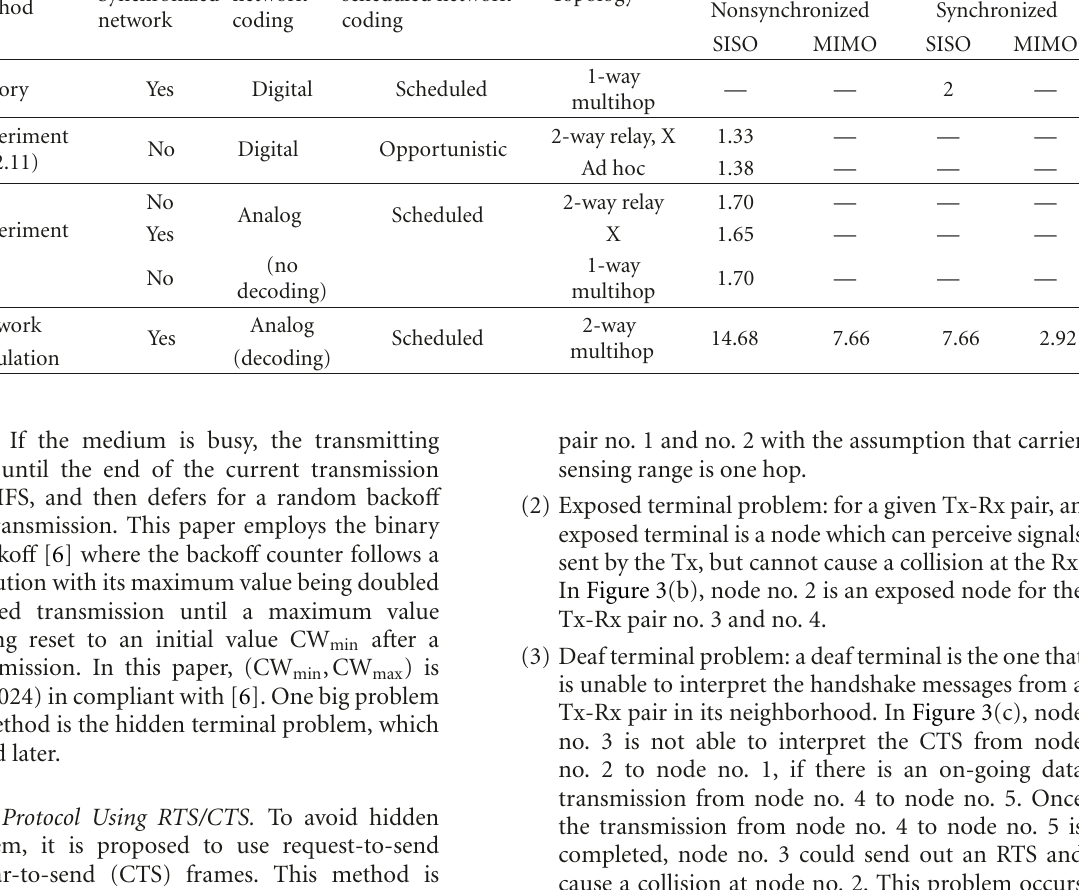
Table 1: Network coding gain in terms of throughput against conventional networks not employing network coding.